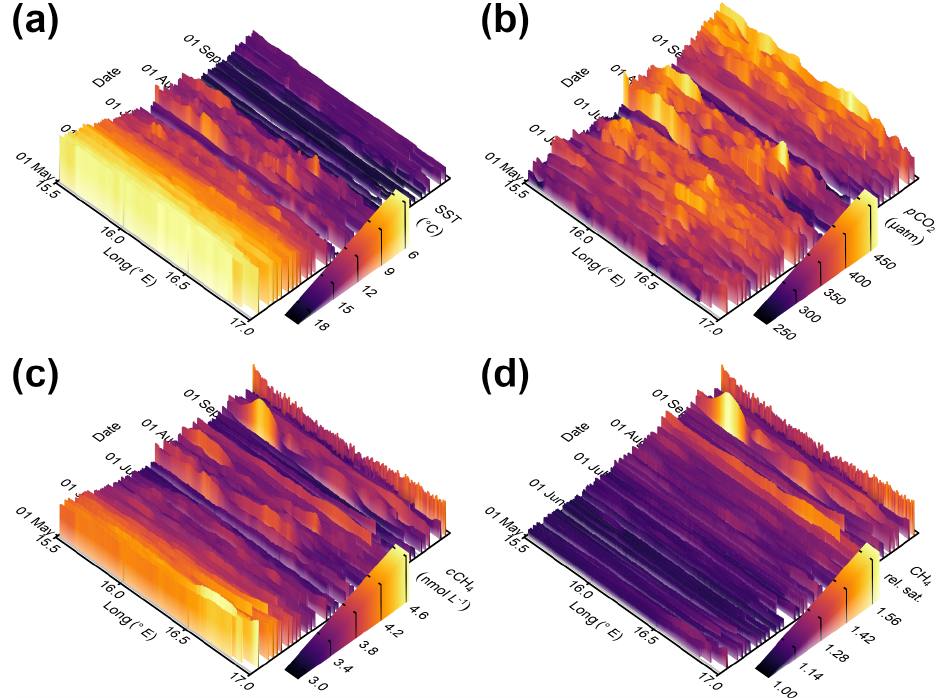
Figure 10. (a) Sea surface temperature, (b) CO 2 partial pressure, (c) CH 4 concentration, and (d) relative CH 4 saturation within the Ö-S box on 82 transects from 2 May to 21 September 2015. In all panels, abscissa is position given as longitude, ordinate is time, and the respective variable is displayed by both colour and height of the curve. Please note the inverted SST scale in (a) to highlight the correlation between decreasing SST and increasing c CH 4 and p CO 2 . Data presented in (a–c) correspond to Fig. 9f and